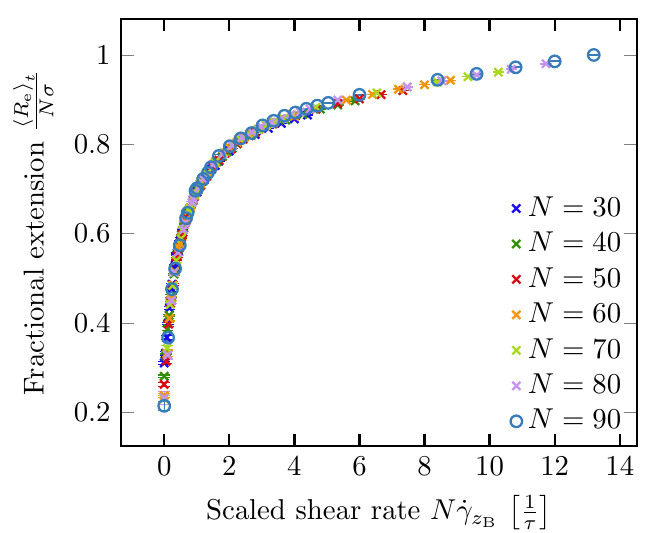
Figure 8. LB/MD simulation results for the fractional extension of a polymer as a function of the shear rate at the boundary ˙ γ z multiplied with the number of monomers N B . Taken from Ref. [86].